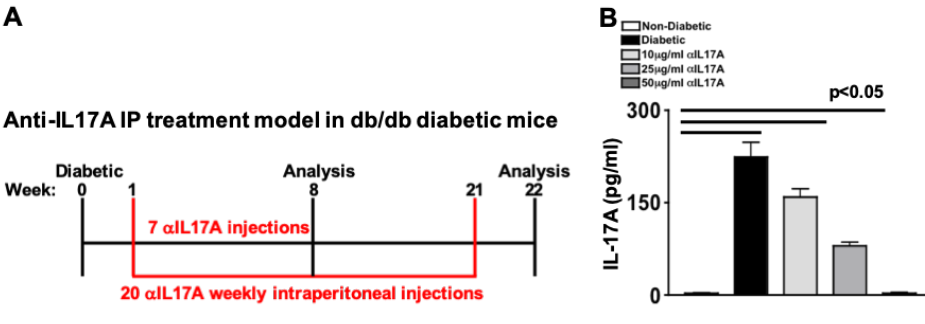
Figure 4. Anti-IL-17A Treatment Regimen of db/db-Type II Diabetic Mice. ( A ) Schematic